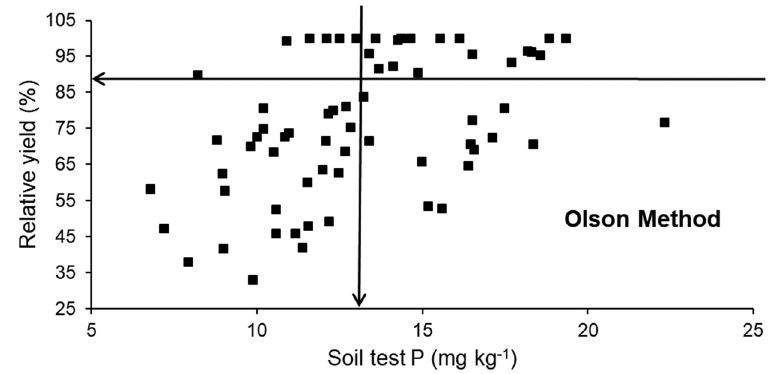
Figure 4: Scatter diagram showing the relationship between soil test P using Olsen method and relative yield of malting barley, and the critical P level.